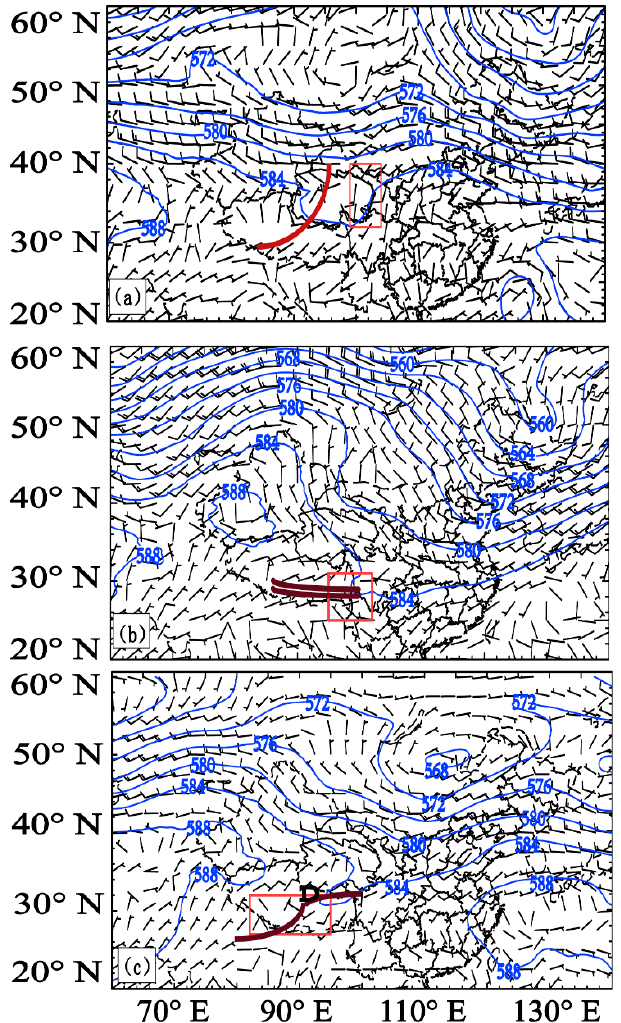
Figure 7. The composite of the 500 hPa circulation for ( a ) PT-type, ( b ) PSL-type, and ( c ) PV-type precipitation events. The blue contour lines represent the potential height (unit: gpm), the red box represents the extreme precipitation area, and the thick red lines indicate the shear line or trough line.